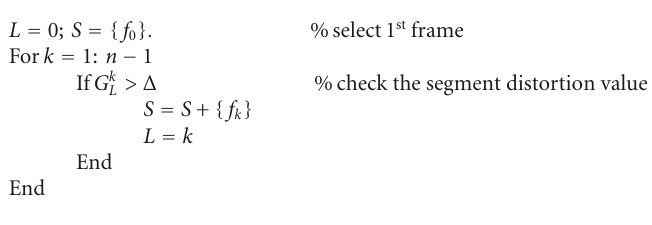
Algorithm 1: Heuristic algorithm pseudo code.